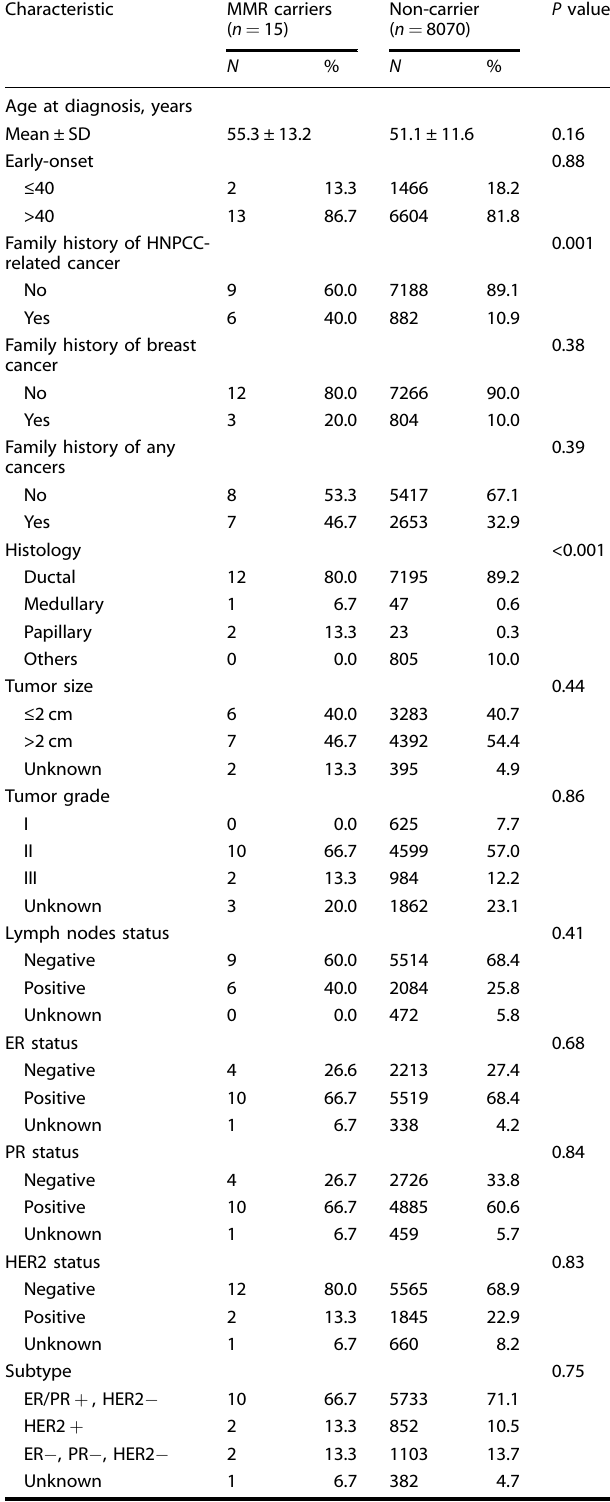
Table 2. Comparison of clinical characteristics between MMR variant carriers and non-carriers in a large cohort of breast cancer patients.